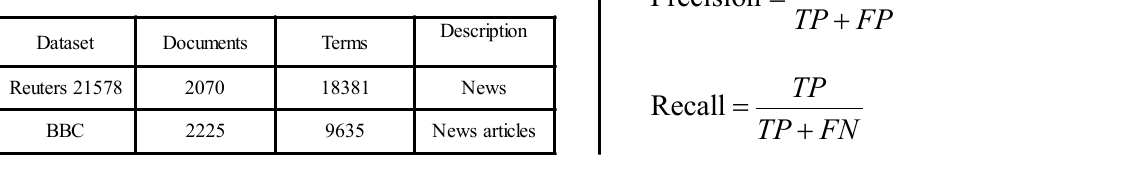
TABLE 2. DATASETS BASIC